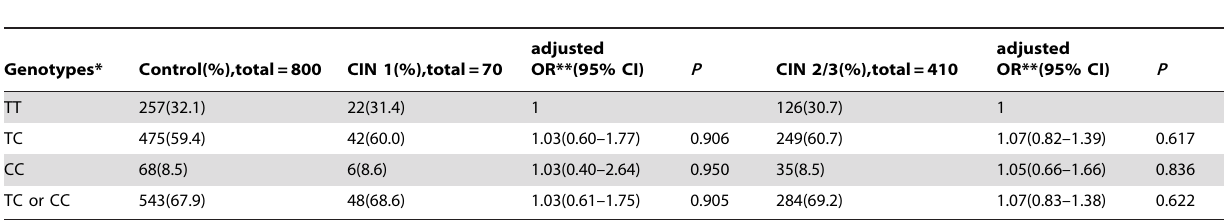
Table 2. Analysis of association between the polymorphisms and risk of CIN.